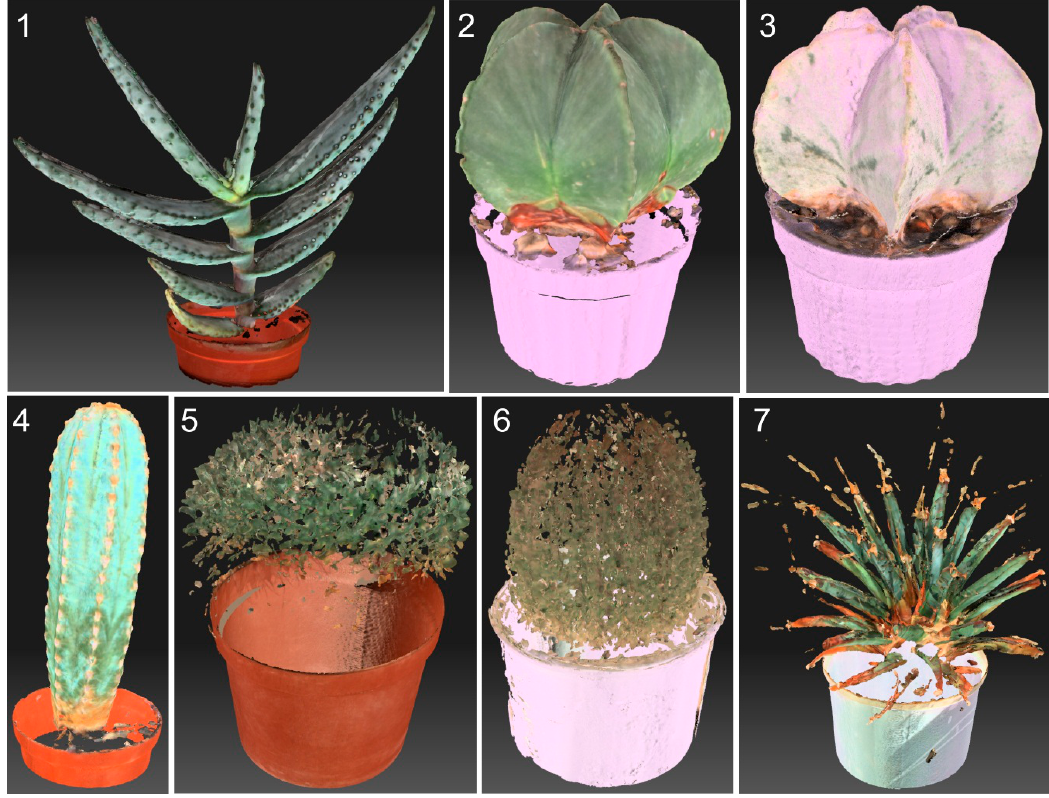
Figure 12. Computer models for plants in Figure 11.